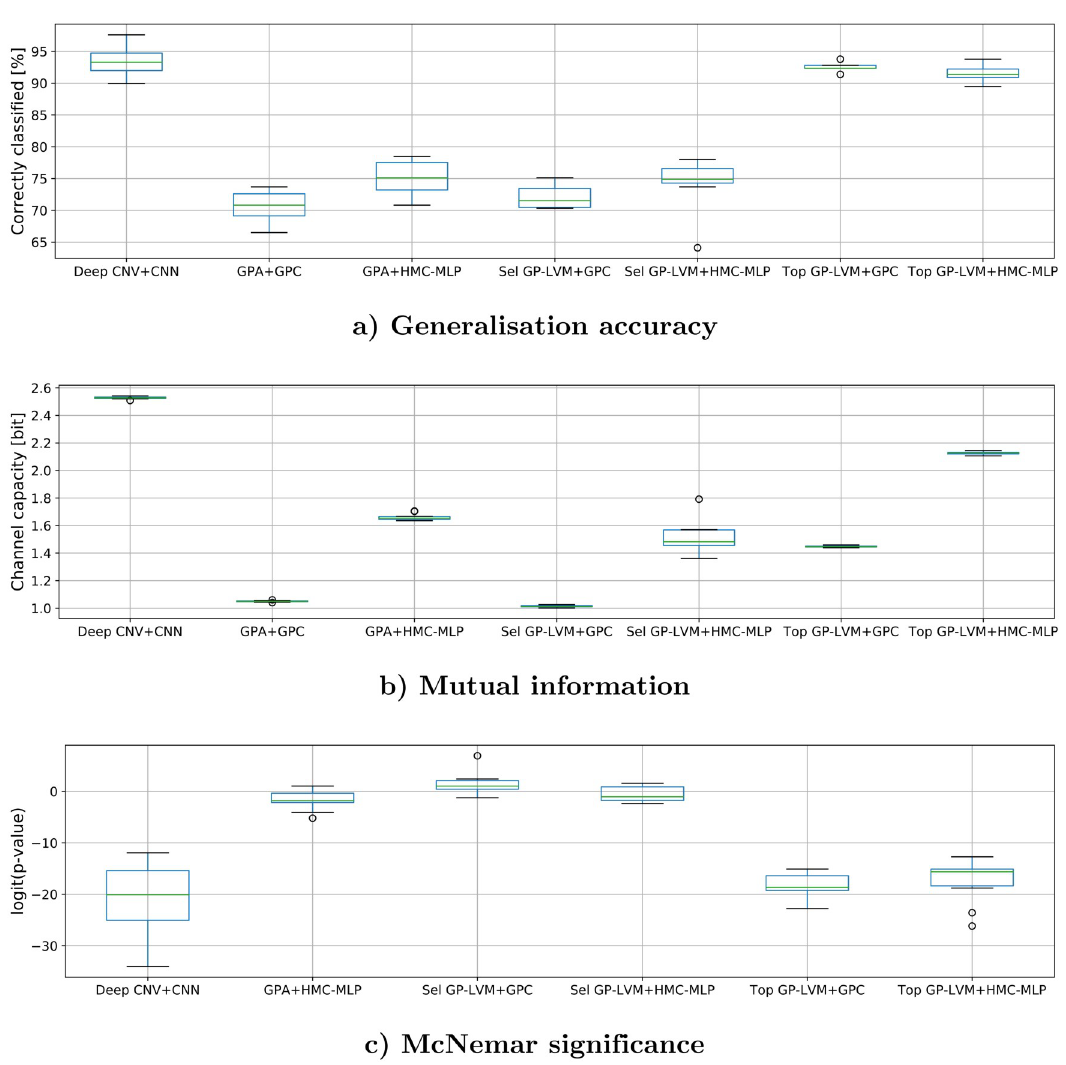
Fig 6. Box plots of generalization metrics that were obtained by resampling. The metric values which give rise to these box plots were obtained by ten fold cross testing after reshuffling the samples ten times. Every box illustrates the performance characteristics of a distinct combination of input feature and classifier. A description of the acronyms is provided in the legend of Table 3 and in the text. a) illustrates generalization accuracies in percent. b) illustrates the distribution of Mutual information and c) visualizes the McNemar p-values on a logit scale when comparing GPA+GPC against the other analysis